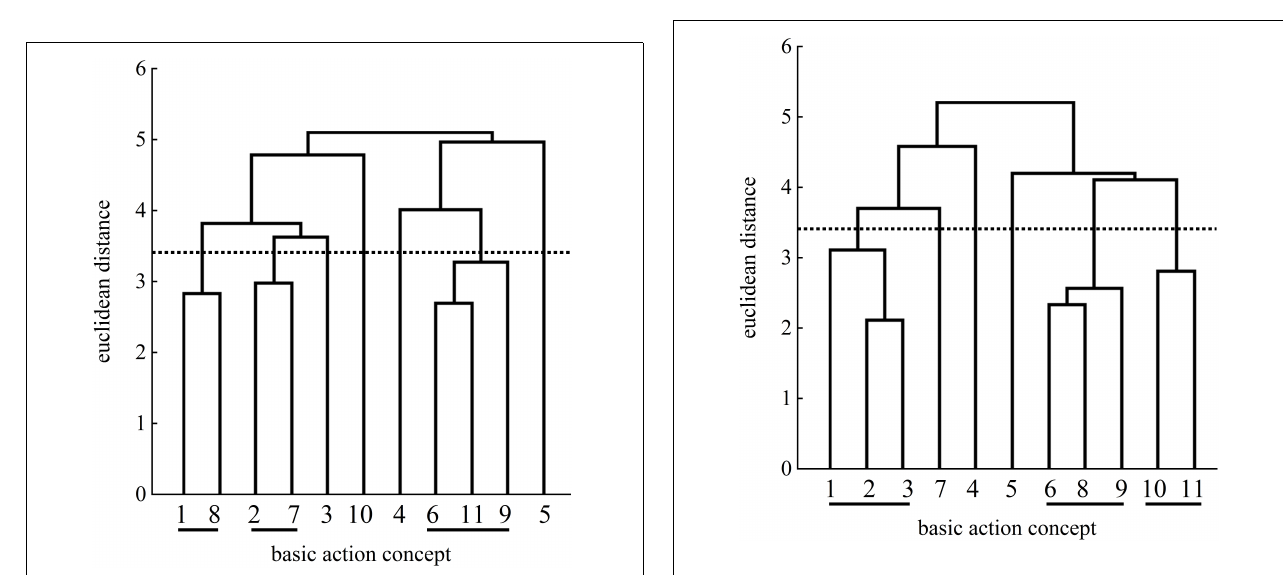
FIGURE 9 | Mean group dendrogram of the explicit group’s ( n = 15) tennis serves on the retention test.